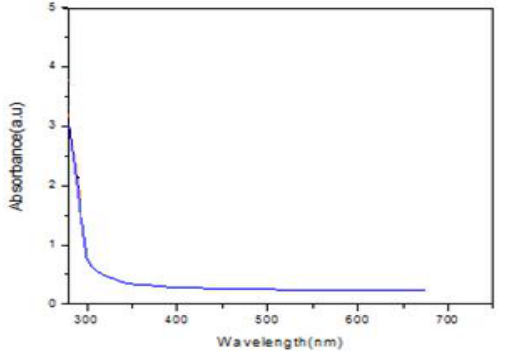
Fig. 7. UV–vis spectra of NiO nanoparticles after calcination .